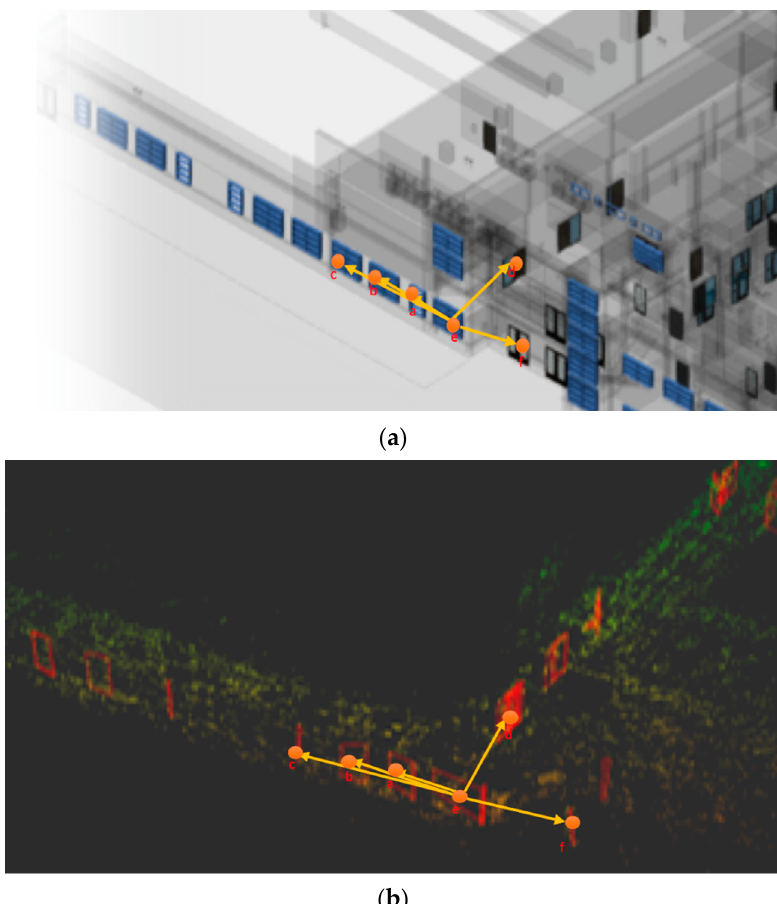
Figure 4. Orientation invariance of the macro-feature description vector. The images show the relative distances and orientation of a few selected macro-features, with 'e' being the microfeature of which the description vector is being calculated. Image ( a ) shows the macro-features in the 3D CAD model while image ( b ) shows the same macro-features in the SLAM map.